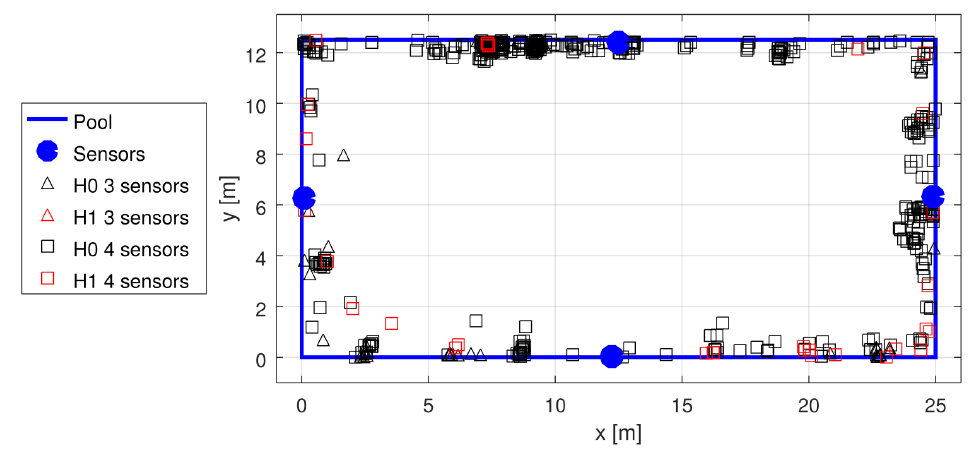
Figure 16. Localization results in sport pool test 2; the transmitter was moved along four sides of the pool.